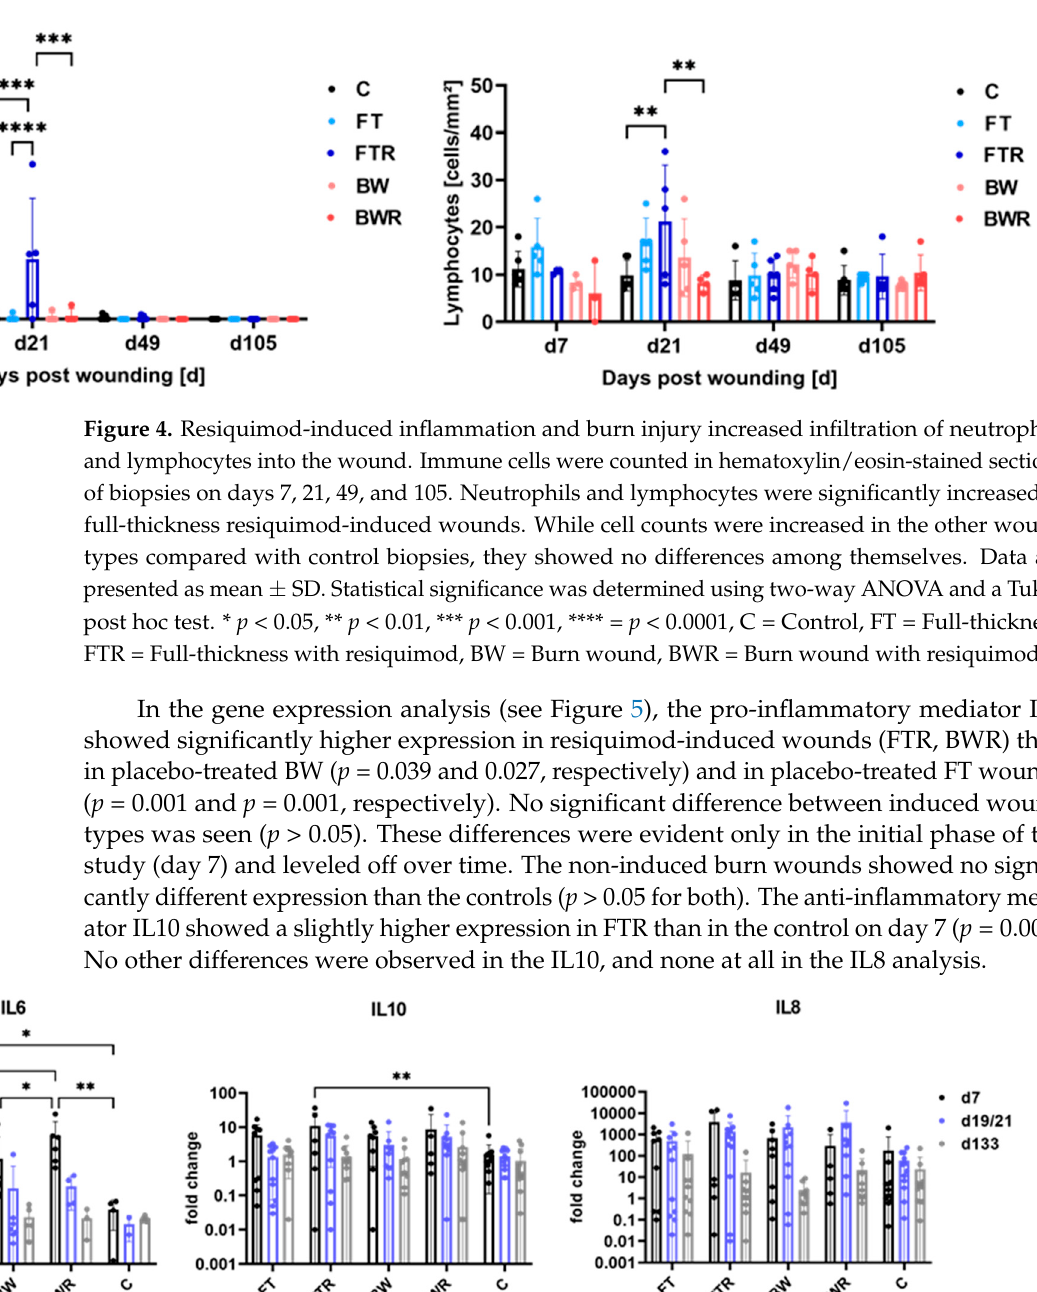
Figure 5. Burn injury and resiquimod induction moderately increased the expression of IL6 and IL10 but had no effect on the expression of IL8. The relative mRNA expression levels of IL6, IL8, and IL10 were determined by qPCR, with target gene expression normalized to the averaged expression of the housekeeping gene YWHAZ. Data are presented as mean (bars) + standard deviation